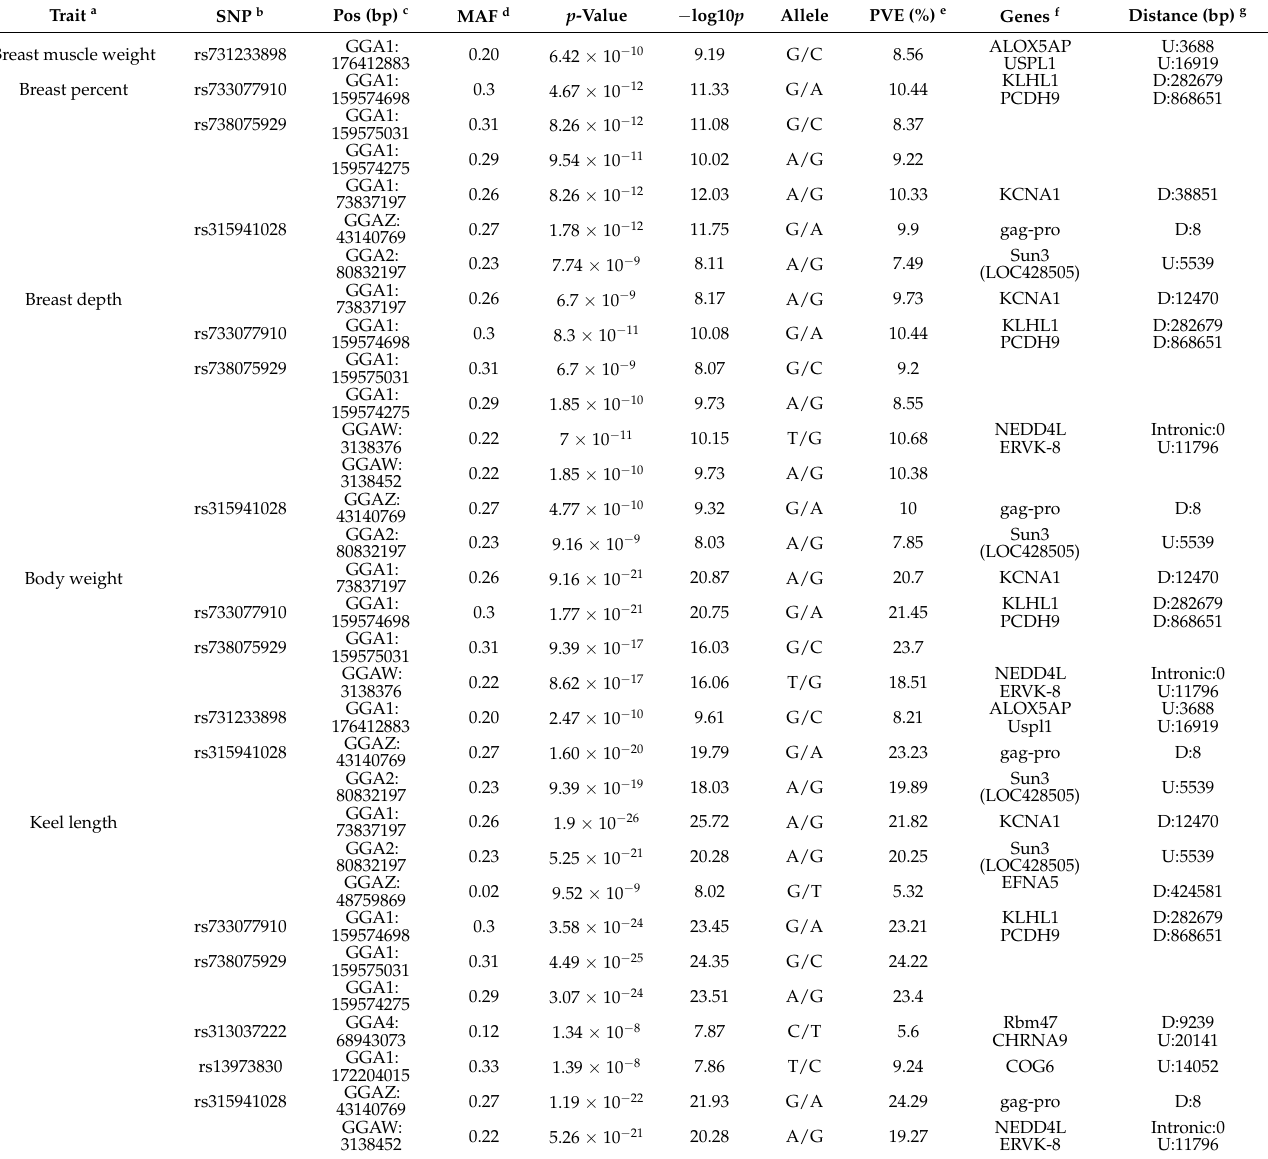
Table 5. The breast muscle development-related trait candidate SNPs and